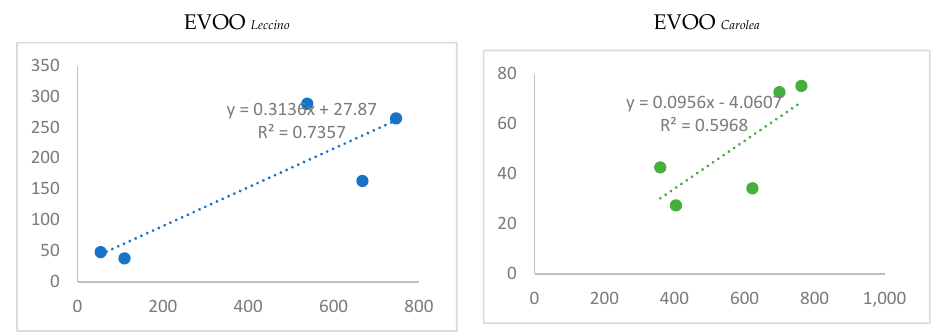
Figure 3. Correlation graphs of secoiridoids and phenolic